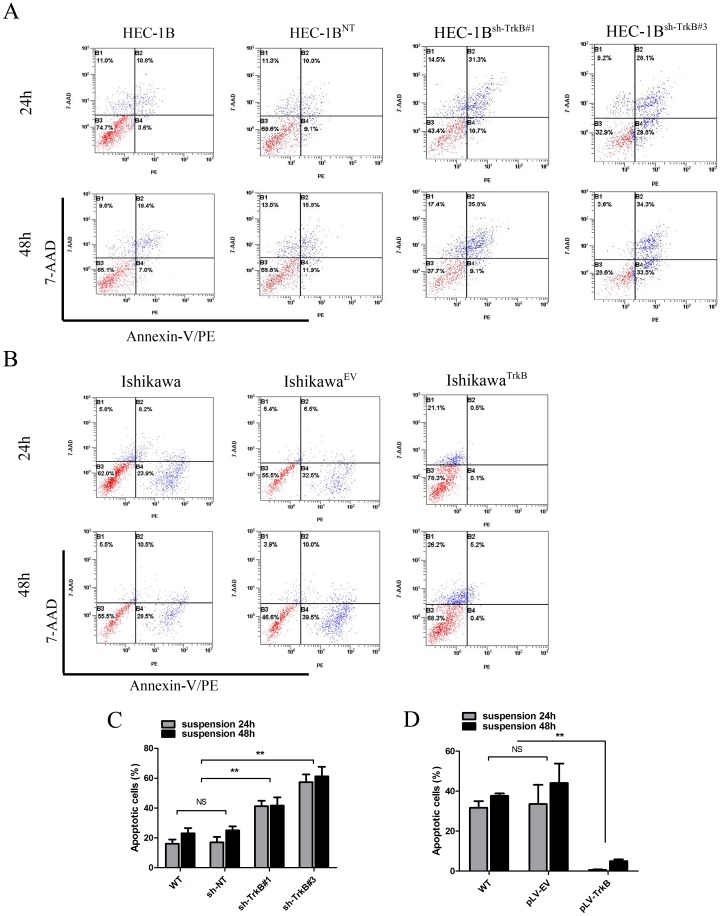
TrkB effects anoikis resistance in suspension culture.A. Representative images of flow cytometry analysis of apoptotic cells by Annexin V-PE/7-AAD staining in HEC-1B cell lines 24 h and 48 h after anchorage-independent culture. B. Representative images of flow cytometry analysis of apoptotic cells by Annexin V-PE/7-AAD staining in Ishikawa cell lines 24 h and 48 h after anchorage-independent culture. C and D. Flow cytometry results were plotted as the mean+SD of triplicate experiments at 24 h and 48 h after suspension culture. **p<0.01 considered significant; NS, not significant. All experiments were carried out in triplicate and repeated at least three times.